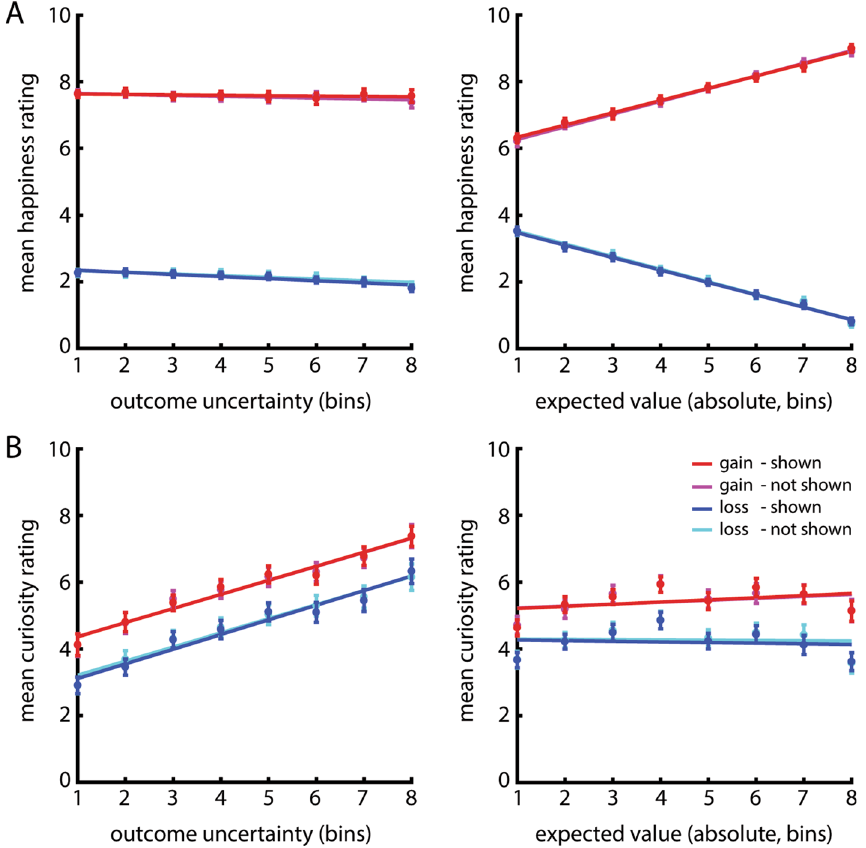
Figure 2. Results of the happiness experiment (a; Experiment 1) and the curiosity experiment (b; Experiment 2). In both panels, the x-axis depicts percentile bins of the values of outcome uncertainty (left) and the absolute values of expected value (right) for both gains (in red; magenta) and losses (in blue; cyan) and for trials in which the outcome was presented (in red; blue) and not presented (in magenta; cyan). The y-axis depicts the mean happiness ratings ( A ) or mean curiosity ratings ( B ) for each percentile of outcome uncertainty and absolute expected value per condition. For other details of the data visualization, see “Methods” section— Data Visualization. ( A ) Experiment 1 showed that happiness was higher for gains than for losses. There was a small but significant decrease in happiness with outcome uncertainty, such that participants were happier about lotteries when outcome uncertainty was lower. There was a monotonic increase of happiness with absolute expected value in the gain trials and a monotonic decrease with absolute expected value in loss trials, such that people were happier about trials with higher wins and lower losses. ( B ) Experiment 2 showed that curiosity was higher for gains than for losses. In contrast with Experiment 1, curiosity increased monotonically with outcome uncertainty in the gain and the loss context, such that participants were more curious about the outcome of lotteries when outcome uncertainty was higher. Curiosity increased with absolute expected value in the gain trials, but there was no effect of absolute expected value in the loss